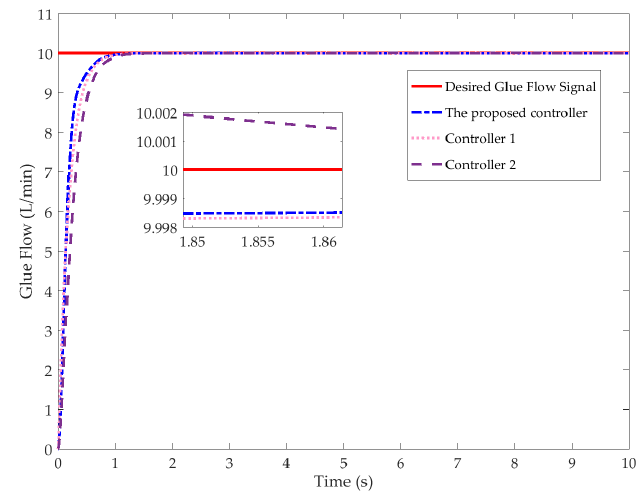
Figure 10. Time response of the glue flow